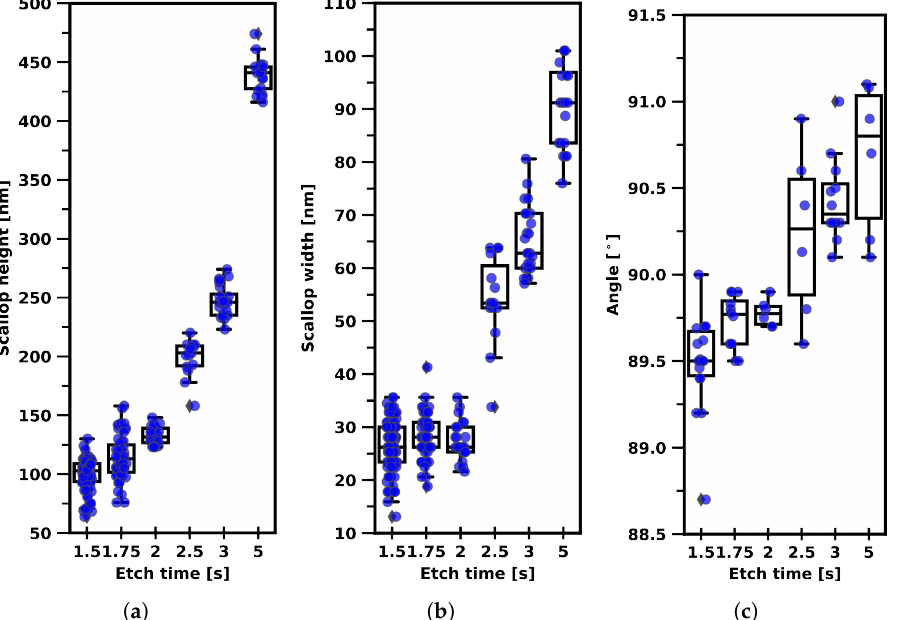
Figure 14. Graphs displaying the scallop height, scallop width, and trench sidewall profile angle for trenches etched with 22W CCP LF platen power and 16mTorr etch process pressure for different etch-cycle times. ( a ) Scallop height vs. etch time. ( b ) Scallop width vs. etch time. ( c ) Sidewall profile angle vs. etch